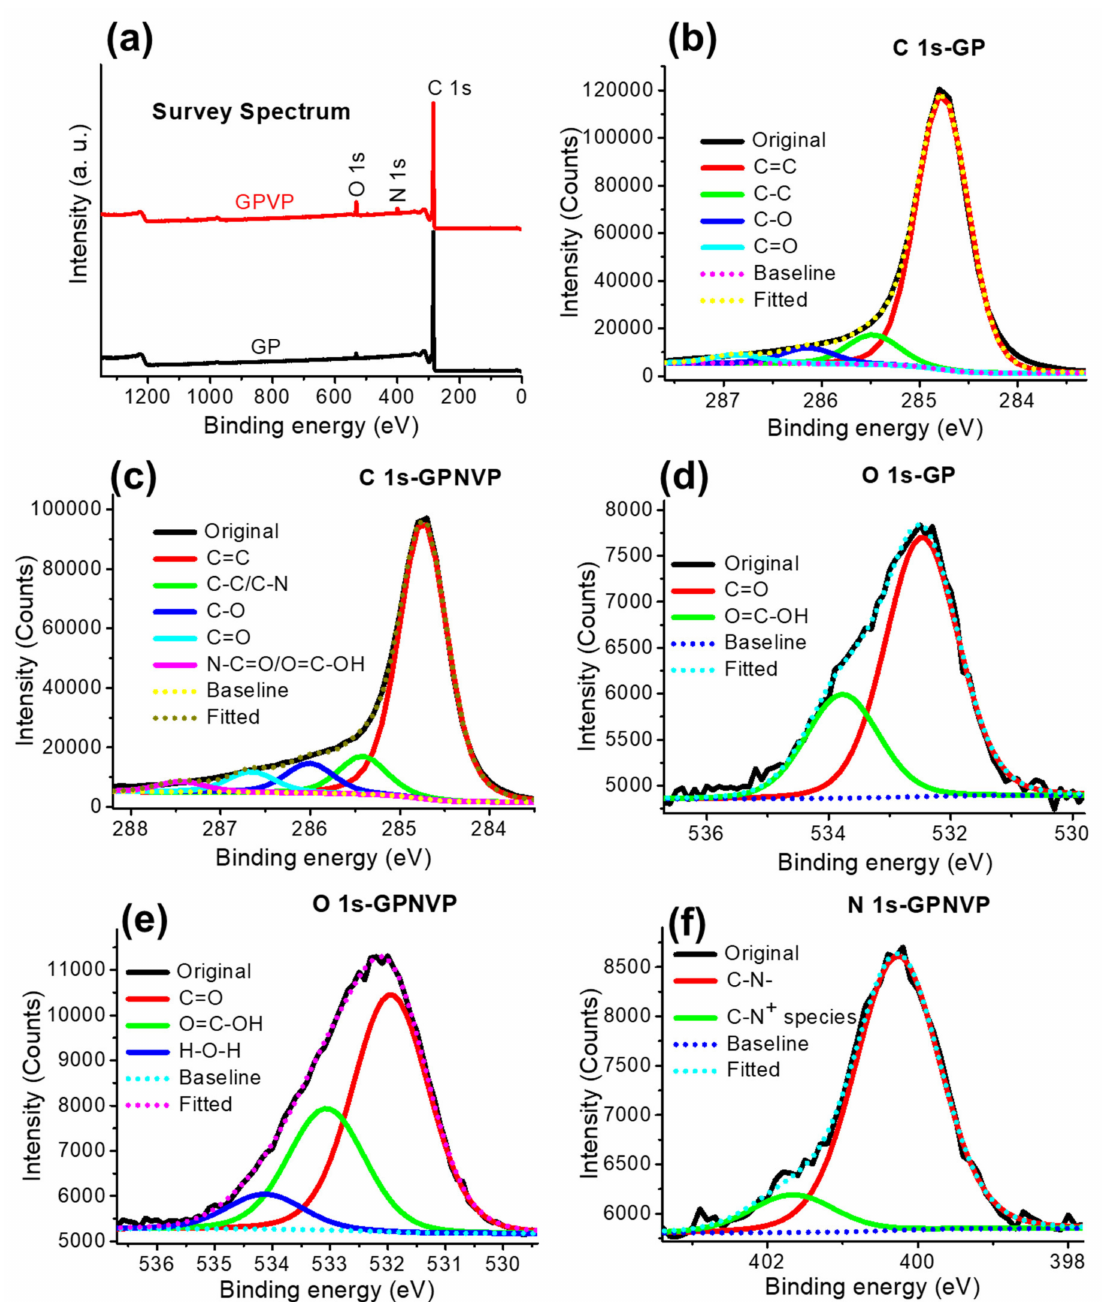
Figure 5. ( a ) XPS survey spectra of GP and GPNVP composite, ( b ) C 1s spectrum of GP, ( c ) C 1s spectrum of GPNVP composite, ( d ) O 1s spectrum of GP, ( e ) O 1s spectrum of GPNVP composite, and ( f ) N 1s spectrum of GPNVP